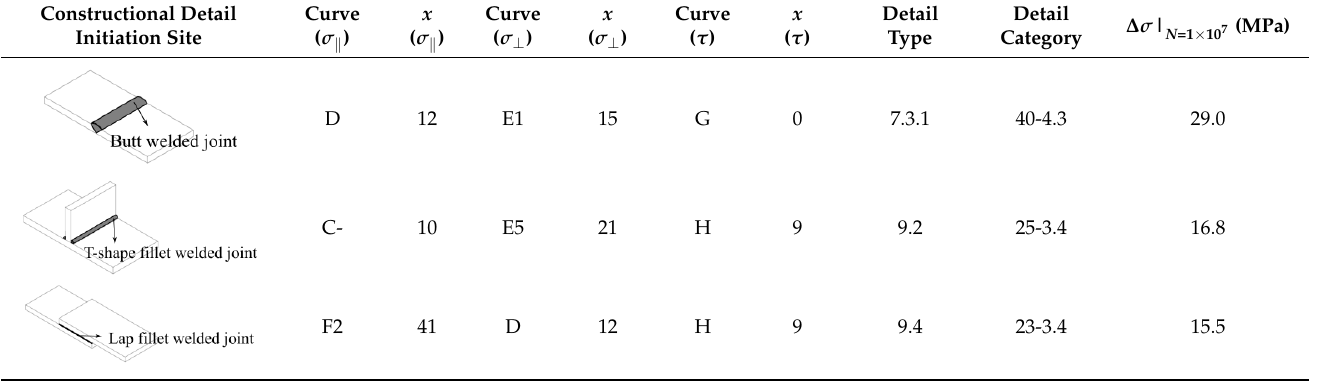
Table 3. Fatigue evaluation assessment results.